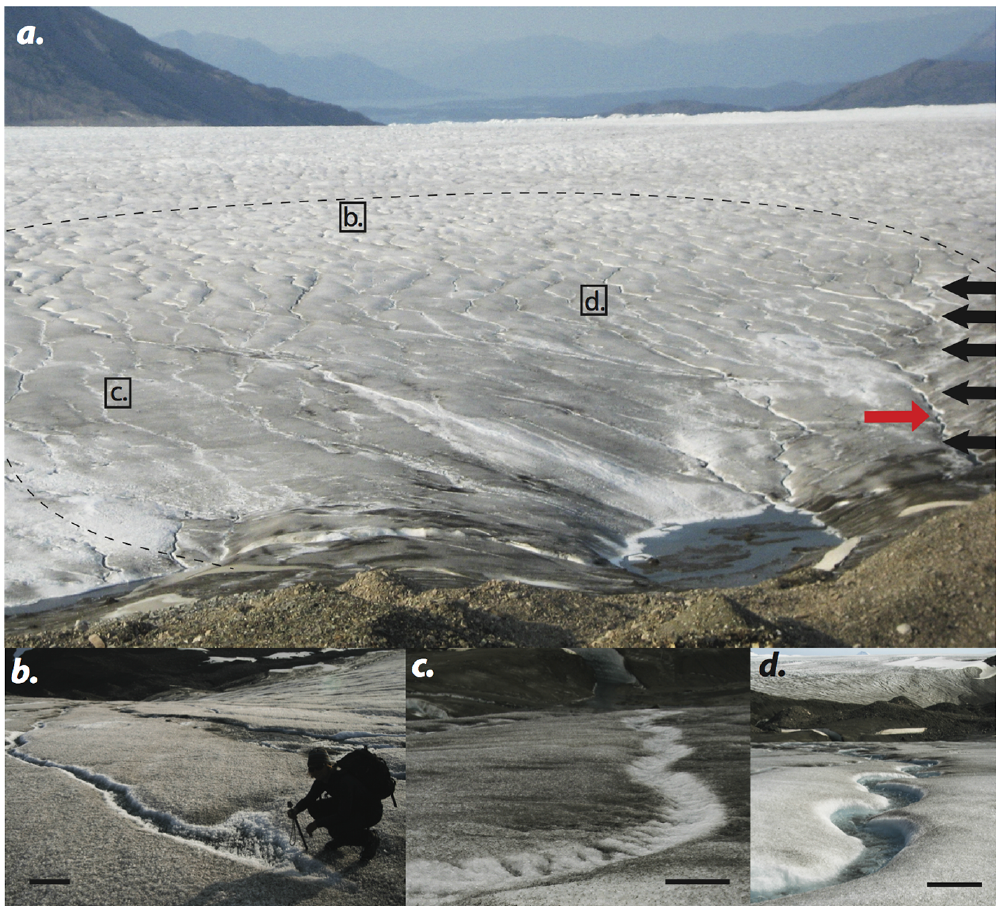
Fig. 2. (a) Marginal region of the Llewellyn Glacier that contains the study drainage basin (dashed line), photo taken from medial moraine. Black arrows indicate starting locations of survey transects, while red arrow is the stream in which the DTS temperature sensor was deployed. Boxed letters provide approximate locations of photographs in subsequent panels. (b) Inception of a supraglacial channel high in the upper study drainage basin, with porous icy substrate surrounding. (c) Recently abandoned channel, note difference in color between recently wetted channel ice and the glacier surface. (d) Example of a highly regular meandering reach. Black scale bars in panels (b–d) are approximately